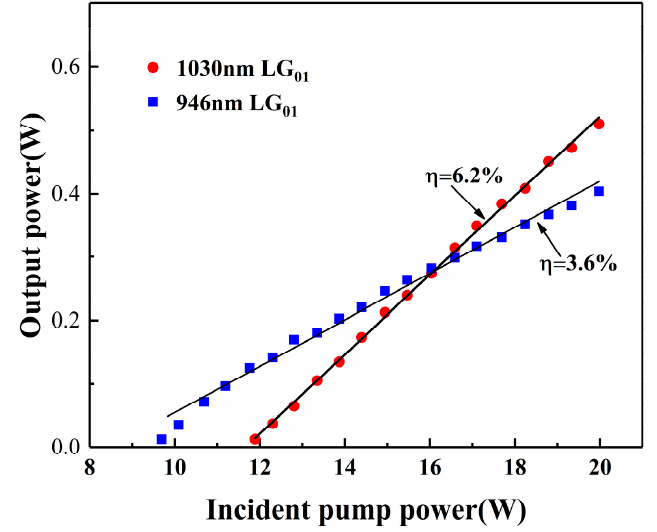
Figure 8. The relationship between the power of the 946/1030 nm LG 01 mode vortex laser and the pump power of the annular beam.